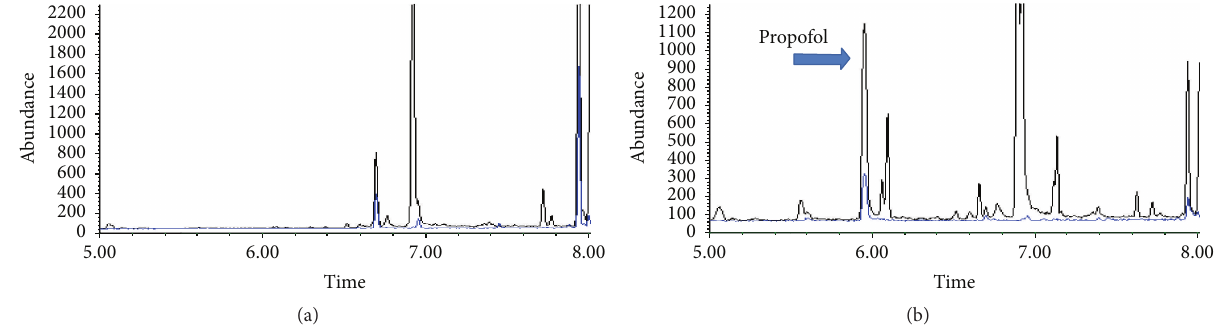
Figure 1: The extracted ion chromatograms of blank sample (a) and propofol spiked plasma sample